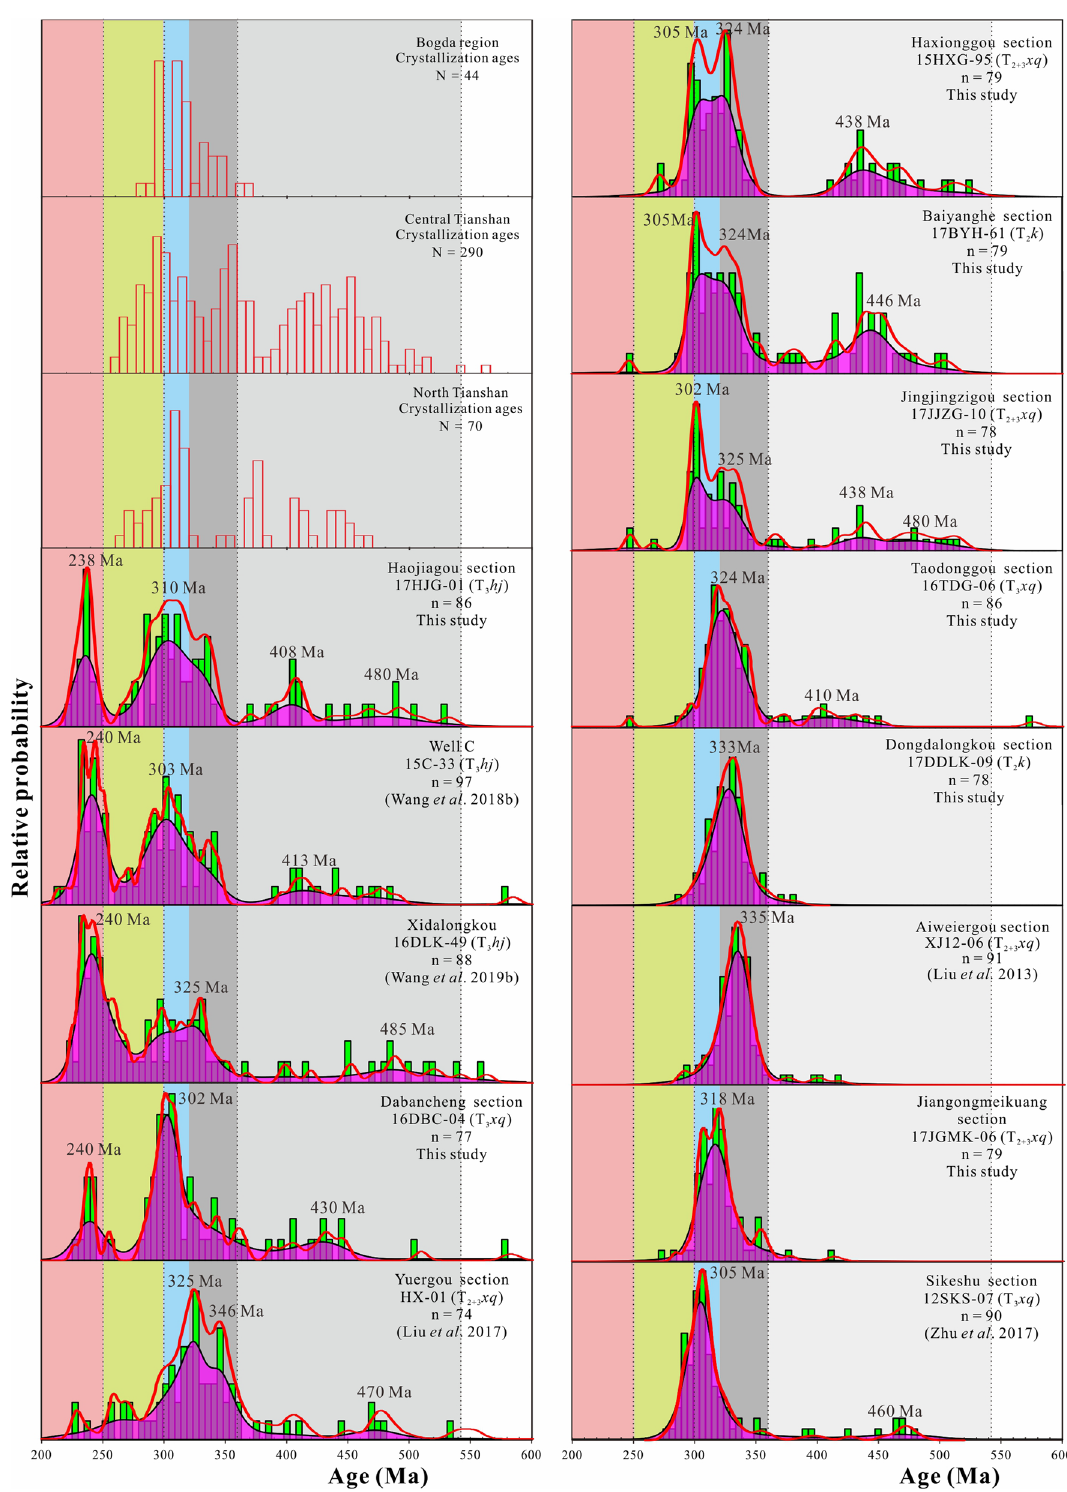
Figure 5. Combination of histograms, probability density plots, and kernel density estimates of detrital zircon grains derived from the Middle–Upper Triassic Xiaoquangou Group in different sections of the southern Junggar Basin. Histograms of crystallization ages from the STS–Tarim, Bogda Mountains, CTS, and NTS areas are also shown for comparison (see 17 for data